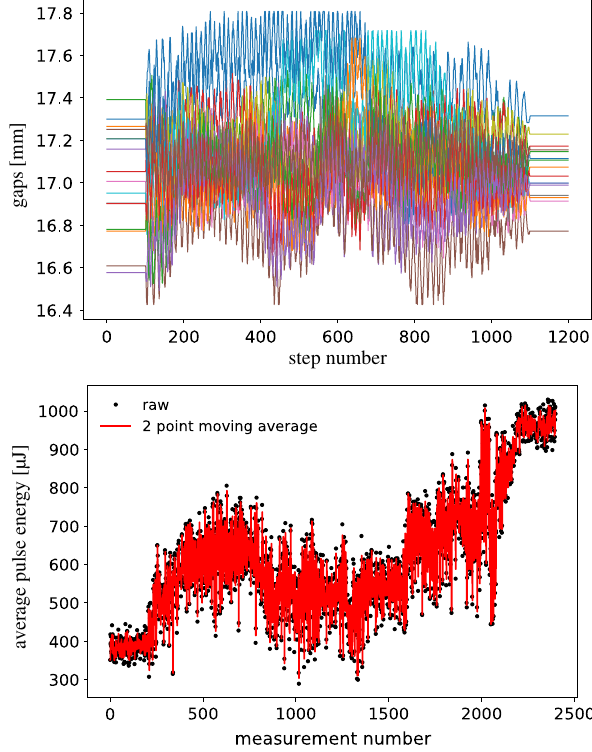
FIG. 5. As the machine slowly drifts, the algorithm continues to adjust 5 phase shifter gaps to maximize average bunch